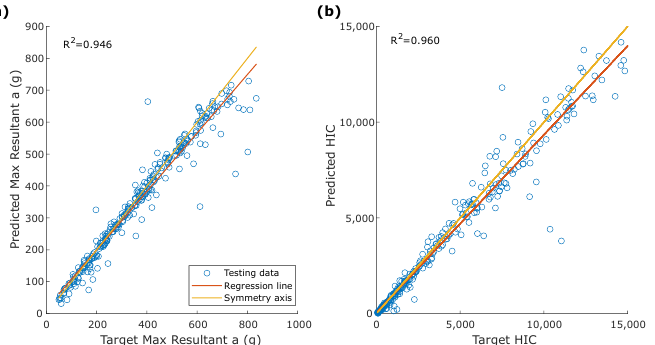
Figure 7. Correlation between ( a ) target and predicted peak for the resultant linear acceleration and ( b ) target and predicted HIC.